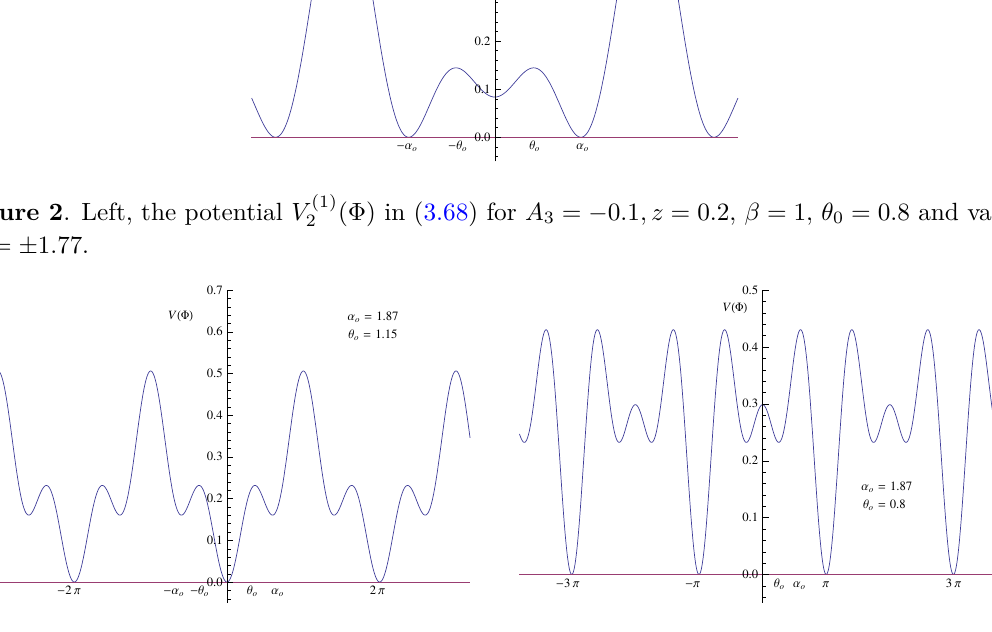
Figure 3 . Left, the potential V (2) (Φ) in (3.70) for A 3 = − 0 . 1 , z = 0 . 3 , β = 1 , θ 0 = 1 . 15 , α o = 1 . 88 2 and vacua ± 2 πn, n ∈ ZZ . Right, the potential V (3) (Φ) in (3.72) for A 3 = 0 . 1 , z = 0 . 3 , β = 1 , θ 0 = 2 0 . 8 , α o = 1 . 88 and vacua ± (2 n + 1) π, n ∈ ZZ .